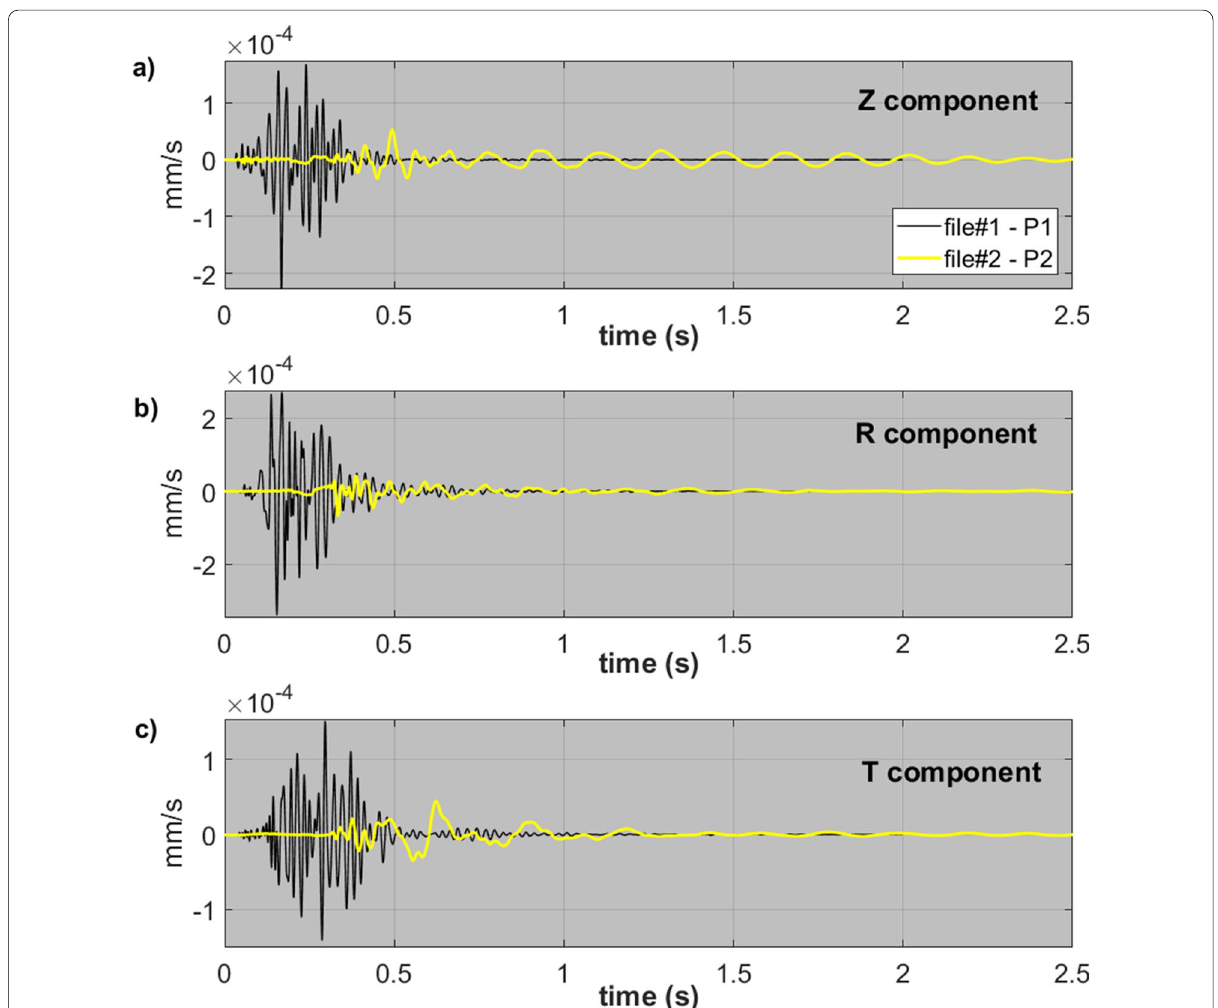
Fig. 11 Beligna#1. Comparison of the HS (active) seismic traces (Z, R and T components) for the central (HS1) and western (HS2) sites (see map in Fig. 8a) [offset is 35 m for both the data sets and the source is the same—see Table 1]. Seismic traces show major differences between the two sites [HS1—black line; HS2—yellow line]: compared to HS2, HS1 signals are faster and have a larger amplitude (i.e., undergo less attenuation). These two facts provide an instantaneous evidence that, compared to the western area [HS2], in the central area (the residual sandy paleo-dune) the surficial sediments are significantly stiffer. To improve data readability, the vertical scales of the three components are different. See also traces and amplitude spectra shown in Fig. 12